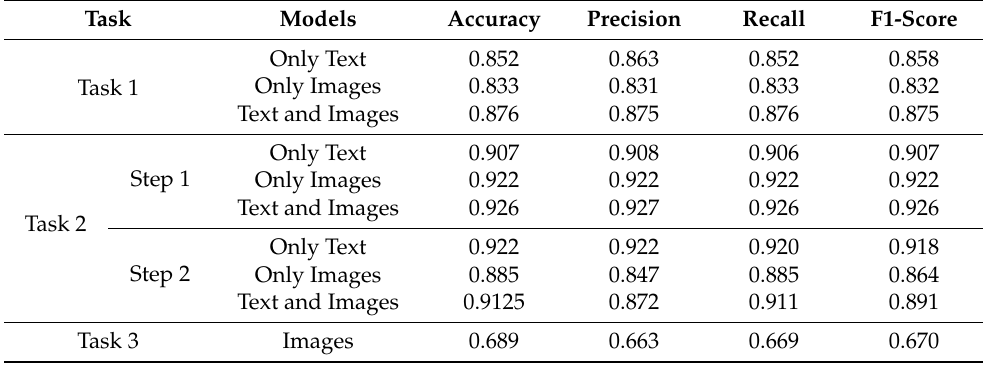
Table 9. The results of experiments.